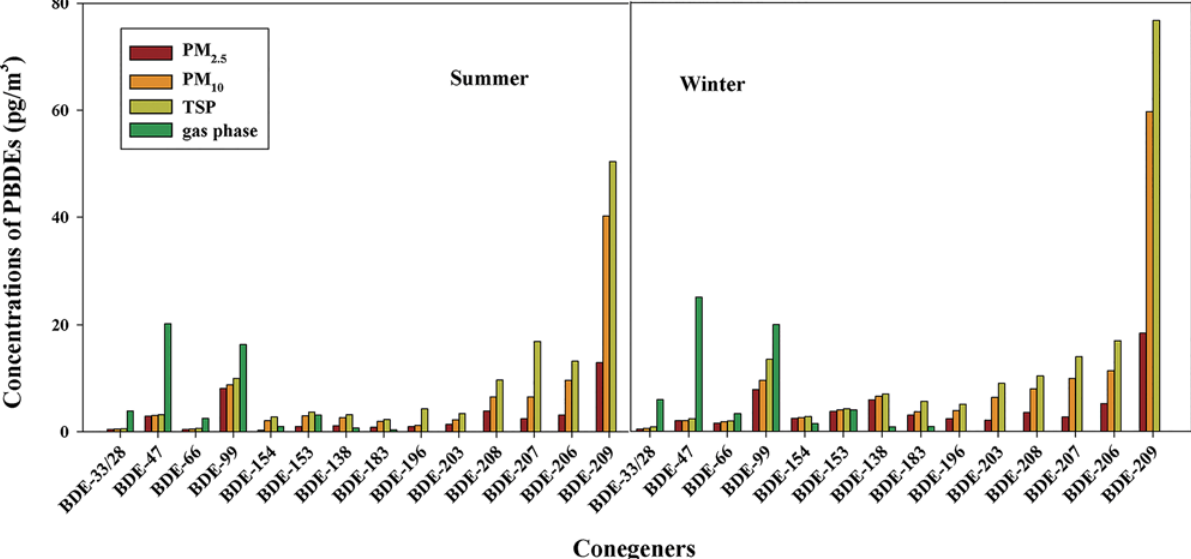
Fig 1. Concentrations of PBDEs congeners in PM 2.5 , PM 10 , TSP and gas phase (Summer: June, July and August 2012; Winter: December 2012, January, and February 2013).